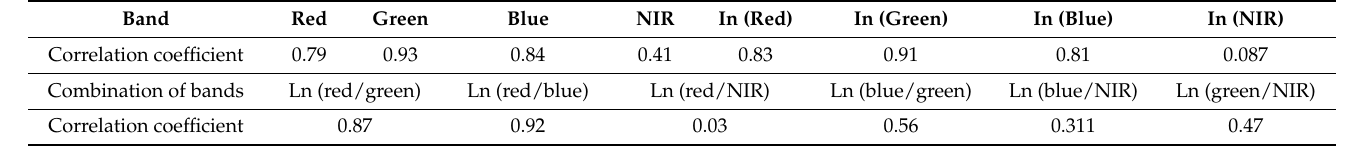
Table 2. Correlation analysis between water depth, band reflectance, and combined